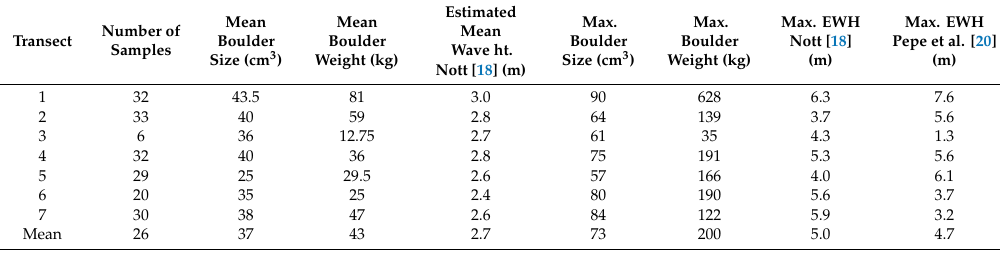
Table 2. Summary data from Appendix A (Tables A1–A7) showing maximum bolder size and estimated weight compared to the average values for sampled boulders from each of the transects together with calculated values for wave heights estimated as necessary for CBD mobility. EWH = estimated wave